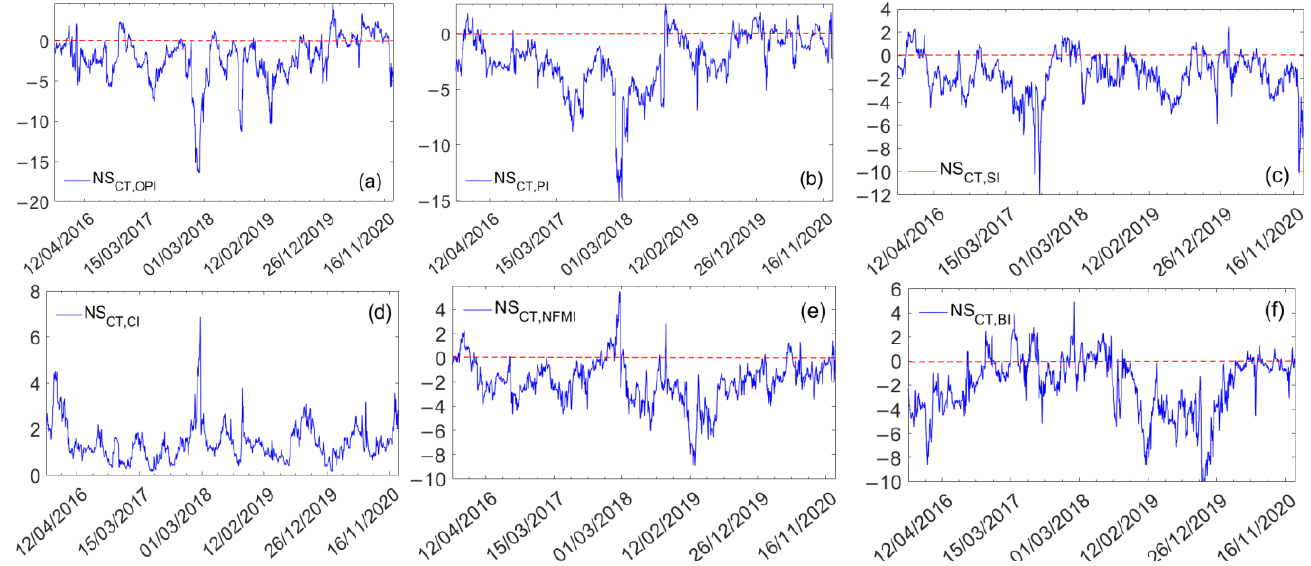
Figure 3. Dynamic evolution of the net volatility spillover index between the carbon (CT) and stock markets across sectors: ( a – f ) present the net volatility spillover index between CT and oil (OPI), electricity (PI), steel (SI), chemicals (CI), non-ferrous metals (NFMI), and banking (BI) sectors, re- spectively.